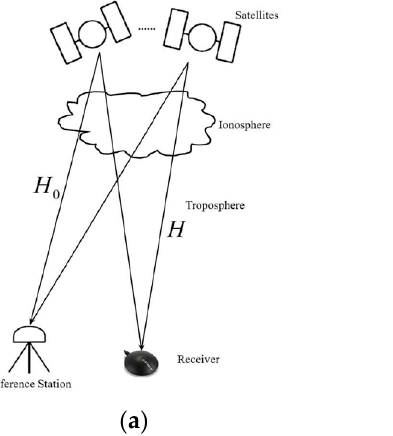
Figure 5. ( a ) GPS receiver geometry with a reference station; ( b ) flowchart of the GPS receiver bias estimation and removal by use of the Kalman filter.